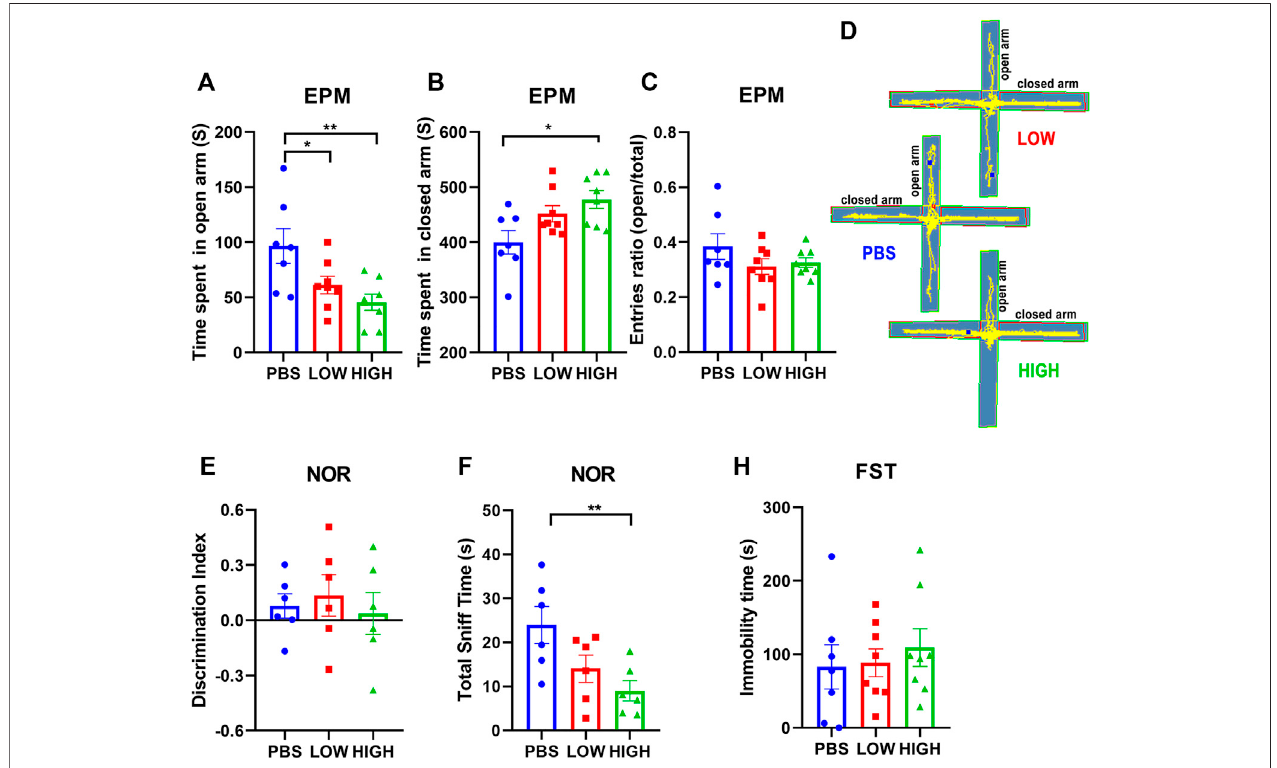
FIGURE 3 | Effects of HCQ on the behavior of mice in the lasting group. (A – D) Elevated plus-maze test. (A) Time spent in the open arms. (B) Time spent in the closed arms. (C) Entries ratio (entries to open arms/(open arms + closed arms). (D) Typical trajectory of mice in the high-dose, low-dose and PBS groups. (E, F) The novel object recognition test. (E) The discrimination index ((novel − familiar)/(novel + familiar)) (F) The total time spent snif fi ng. (G) The immobility time in the forced swim test ( n (cid:1) 7 − 8 for each subgroup in EPM and FST; n (cid:1) 6 for each subgroup in NOR; one-way ANOVA; * p < 0.05, ** p < 0.01).